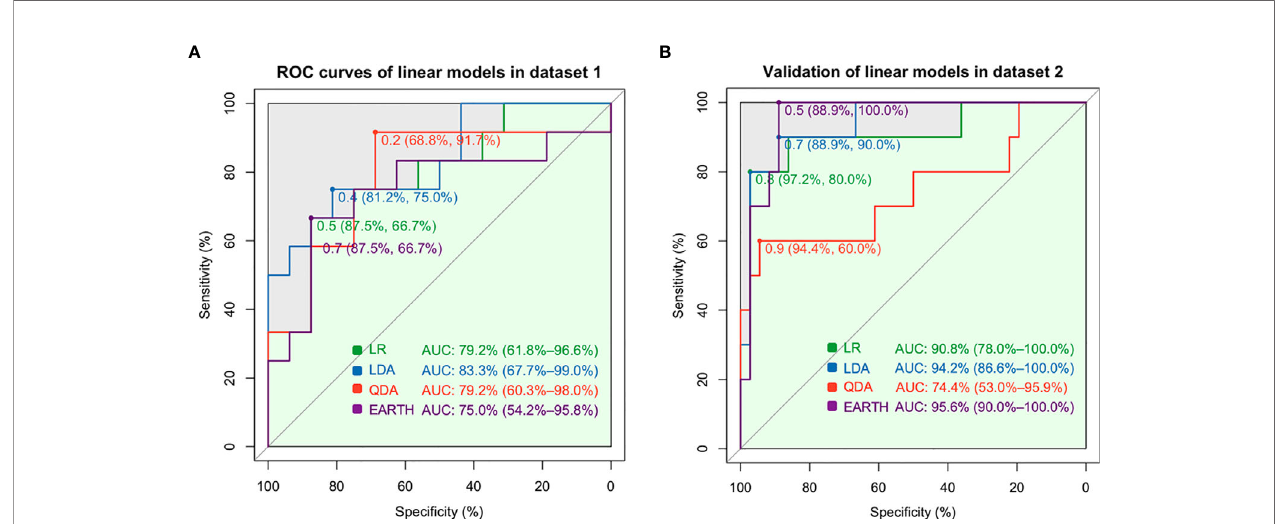
FIGURE 2 | Prediction assessment and validation of the linear models. (A) The AUCs were 79.2% for the LR, 83.3% for LDA, 79.2% for QDA, and 75.0% for MARS in dataset 1. (B) The AUCs were 90.8% for LR, 94.2% for LDA, and 74.4% for QDA in dataset 2.